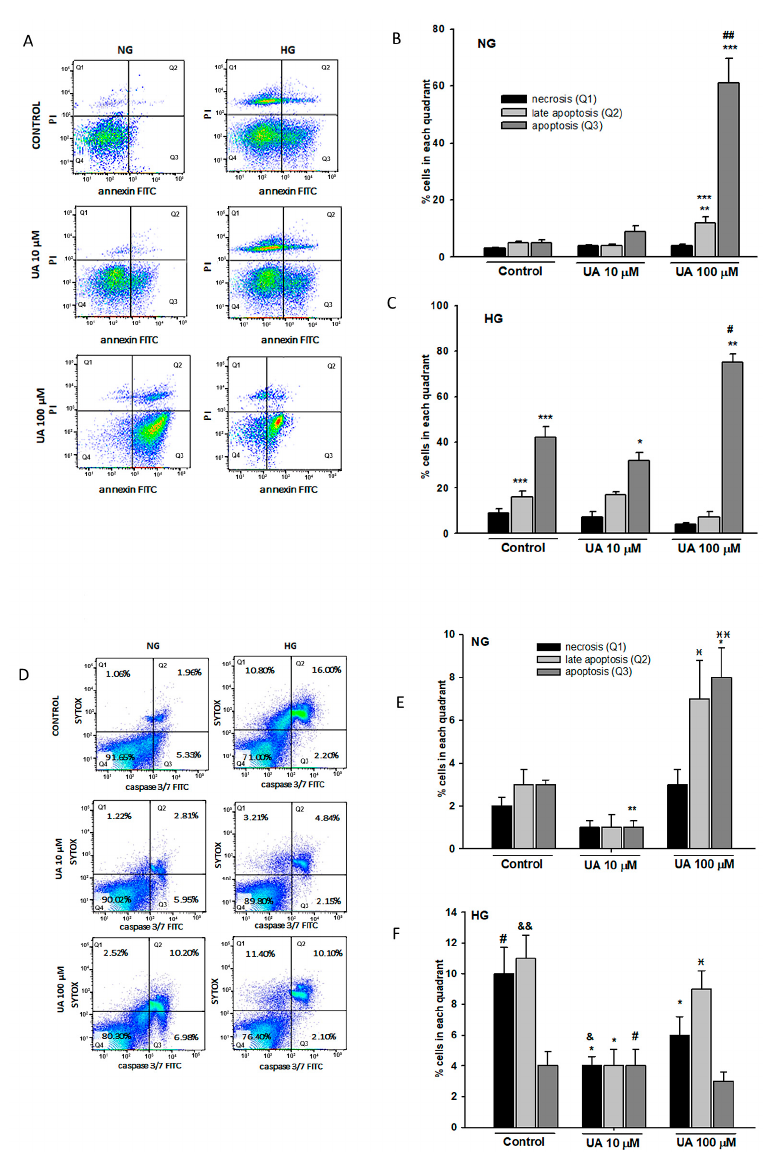
Figure 7. 100 µ M UA induced podocyte apoptosis. Podocytes cultured for 7 d in normal (5.5 mM, NG) or high (25 mM, HG) glucose were treated with 10 µM and 100 µM UA for 24 h. Representative flow cytometry images of Annexin V/Propidium Iodide (PI) double-staining ( A ) and quantitative analysis of podocyte apoptosis ( B , C ). Representative flow cytometry images of activated caspase-3/7 ( D ) quantitative analysis of activated caspase-3/7 detection ( E , F ). Sytox Green nucleic acid stain was used as an indicator of necrotic cells. ANOVA and the Student’s t -tests were used to calculate p values. For ( B , C ) * p < 0.05 vs. HG Control, # p < 0.01 vs. HG Control, ** p < 0.01 vs. respective 10 µM UA, ## p < 0.001 vs. NG- 10 µM UA, *** p < 0.001 vs. NG Control. For ( E , F ) * p < 0.05 vs. Control, ** p < 0.01 vs. Control, ♓ p < 0.05 vs. 10 µM UA, ♓♓ p < 0.01 vs. 10 µM UA, # p < 0.05 vs. respective NG group, & p < 0.01 vs. respective NG 10 µ M UA, && p < 0.005 vs. NG Control. The values are mean ± SEM ( n = 4 for ( B , C ), n = 3 for ( E , F )). We also measured caspase 3/7 activity to confirm that the reduced podocyte viability reflected changes in podocyte apoptosis. The cells were simultaneously stained with